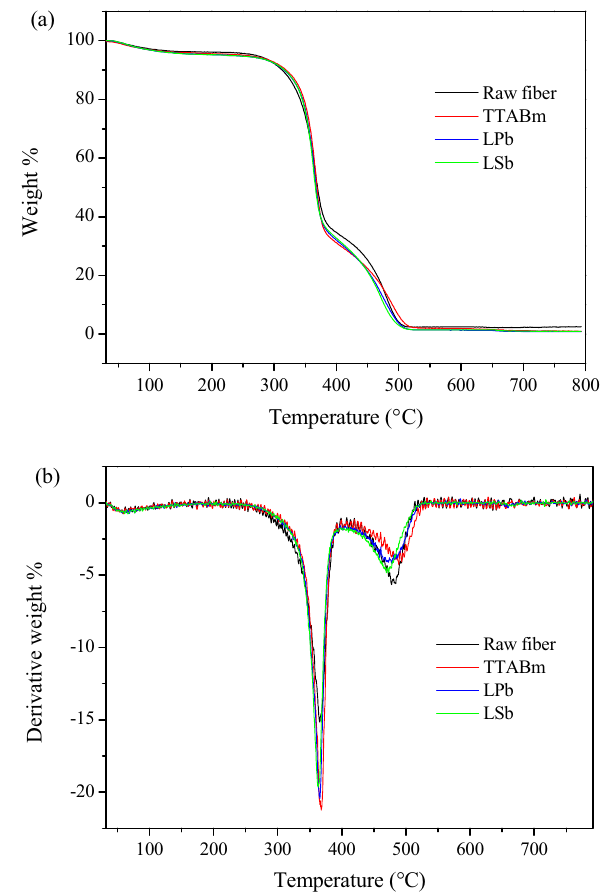
Figure 6. TG curves ( a ) and DTG curves ( b ) of the raw fiber and TTABm, LPb and LSb samples.